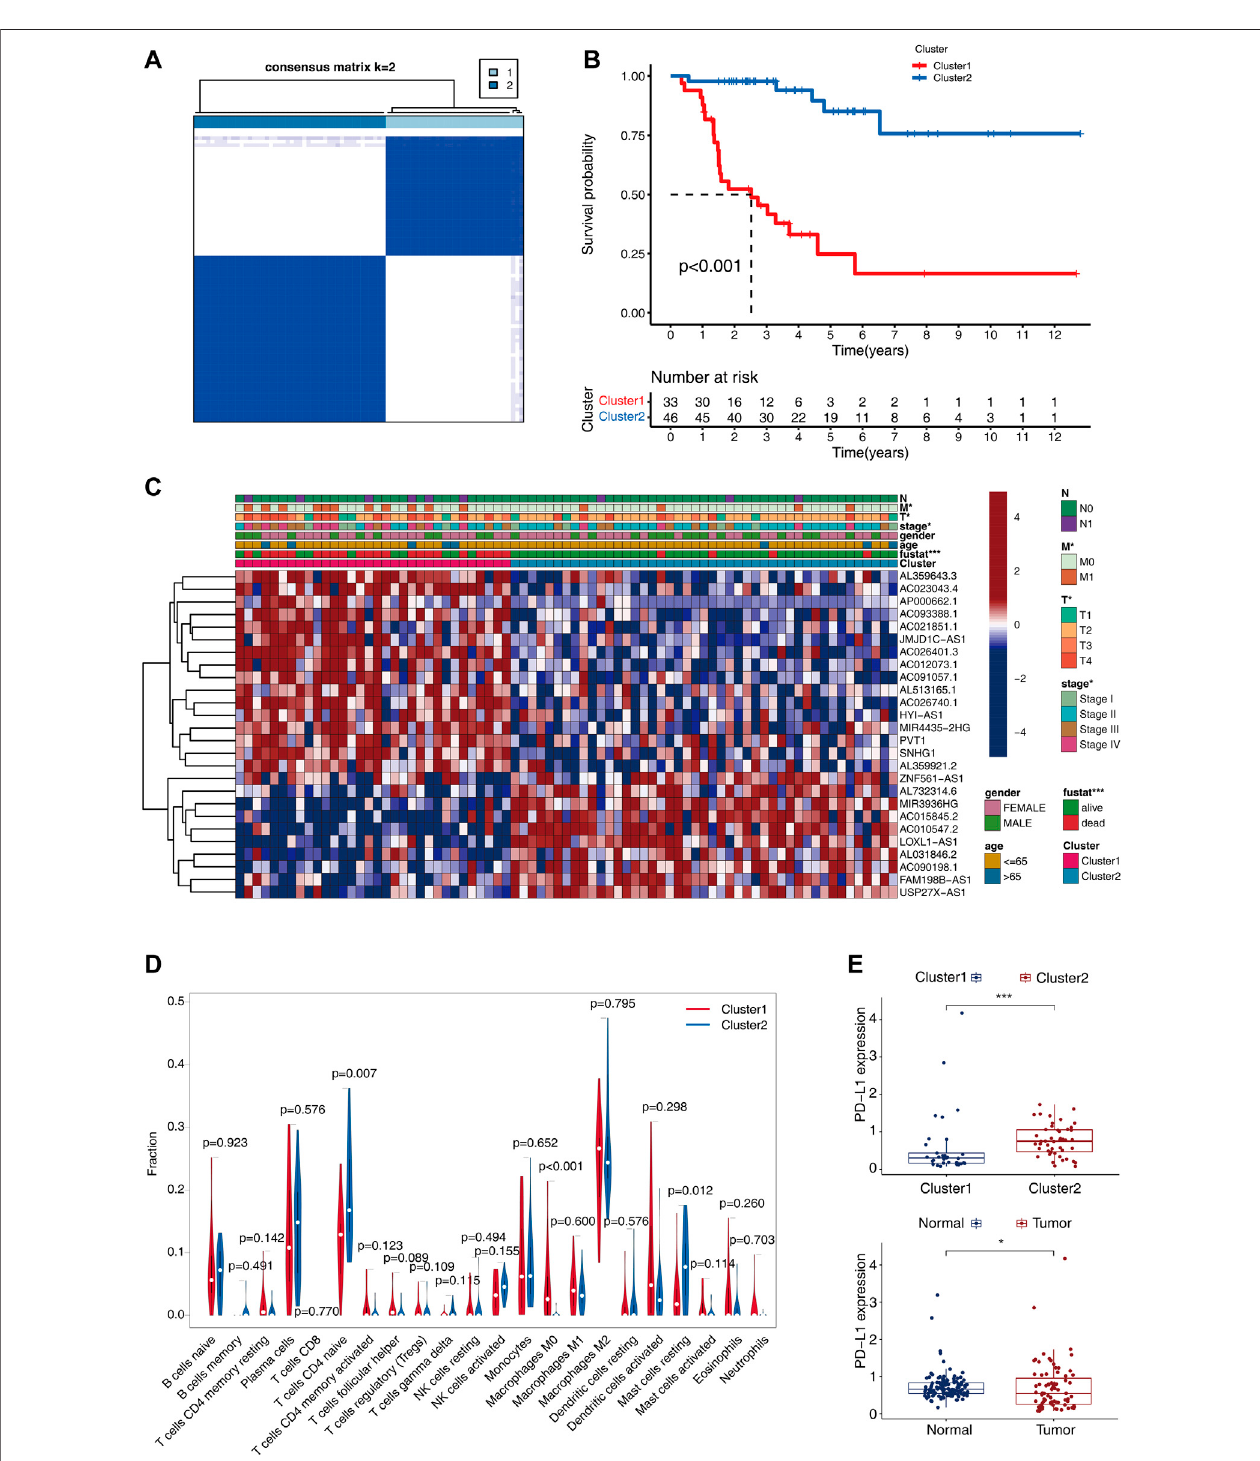
FIGURE 3 | Consensus clustering for the 79 ACC patients premised on the 26 m6A-related lncRNAs with prognostic signi fi cance. (A) The consensus clustering matrix at k = 2. (B) The differences in OS between the two clusters. (C) Heatmap shows the correlation between the expressions of the 26 m6A-related lncRNAs and clinical-pathological characteristics of ACC. (D) With the aid of the CIBERSORT algorithm, substantial differences in the in fi ltrating levels of 22 distinct immune cell types between the 2 clusters are analyzed. (E) Differential expression of PD-L1 between the 2clusters (upper), and normal and tumor tissues (below).